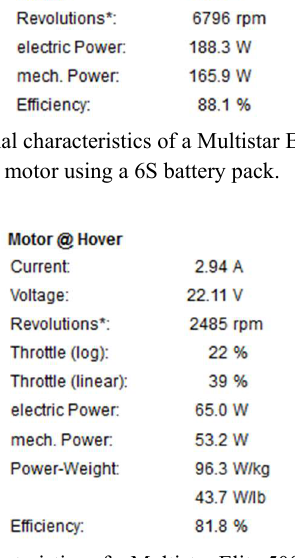
Table 2. Characteristics of a Multistar Elite 5008-330 motor using 18” 5.5” pitch propeller and a 6S battery pack.